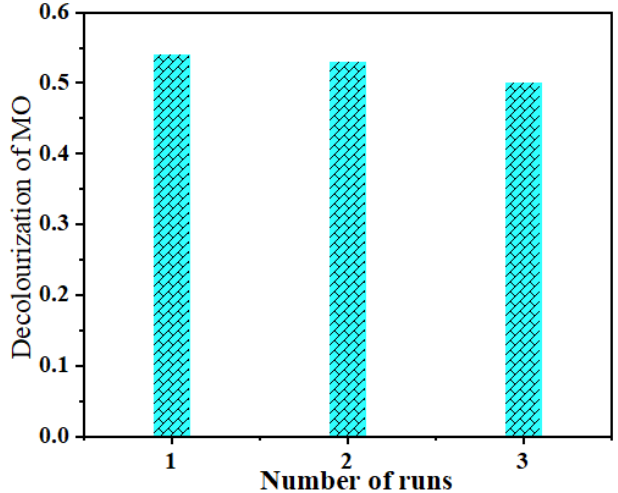
Figure 13. Cyclic testing of photocatalytic performance of T/B-2.